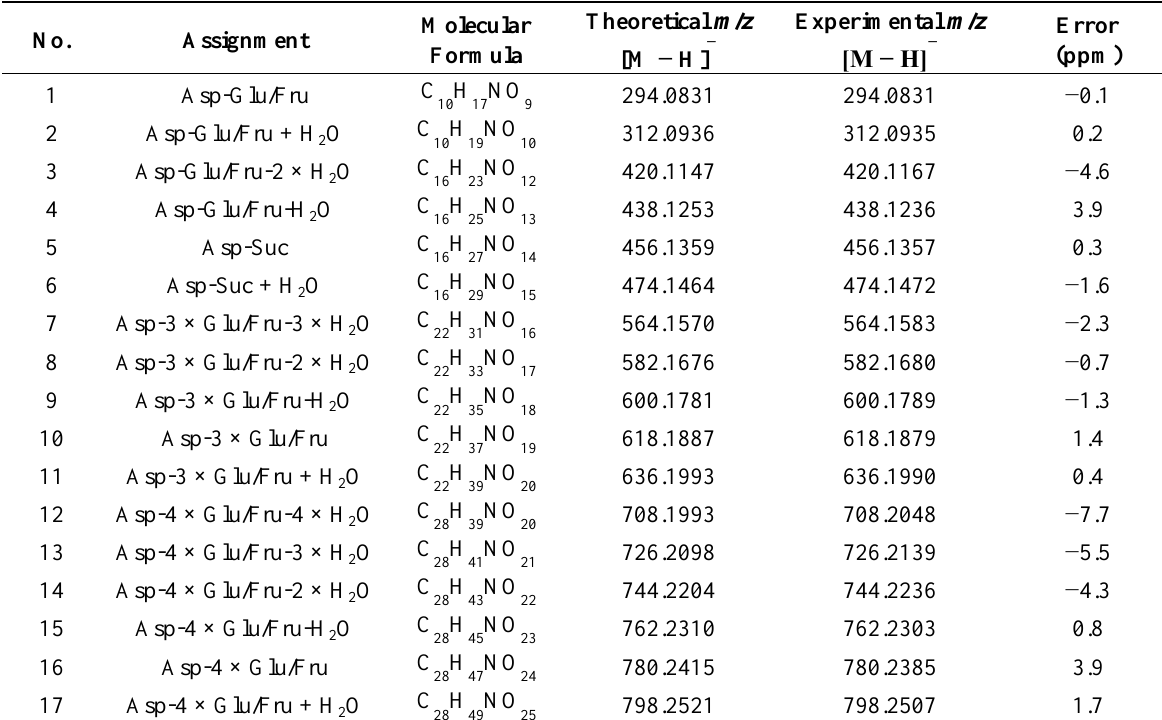
Table 2. ESI-TOF-MS data in negative ion mode of a reaction of aspartic acid with